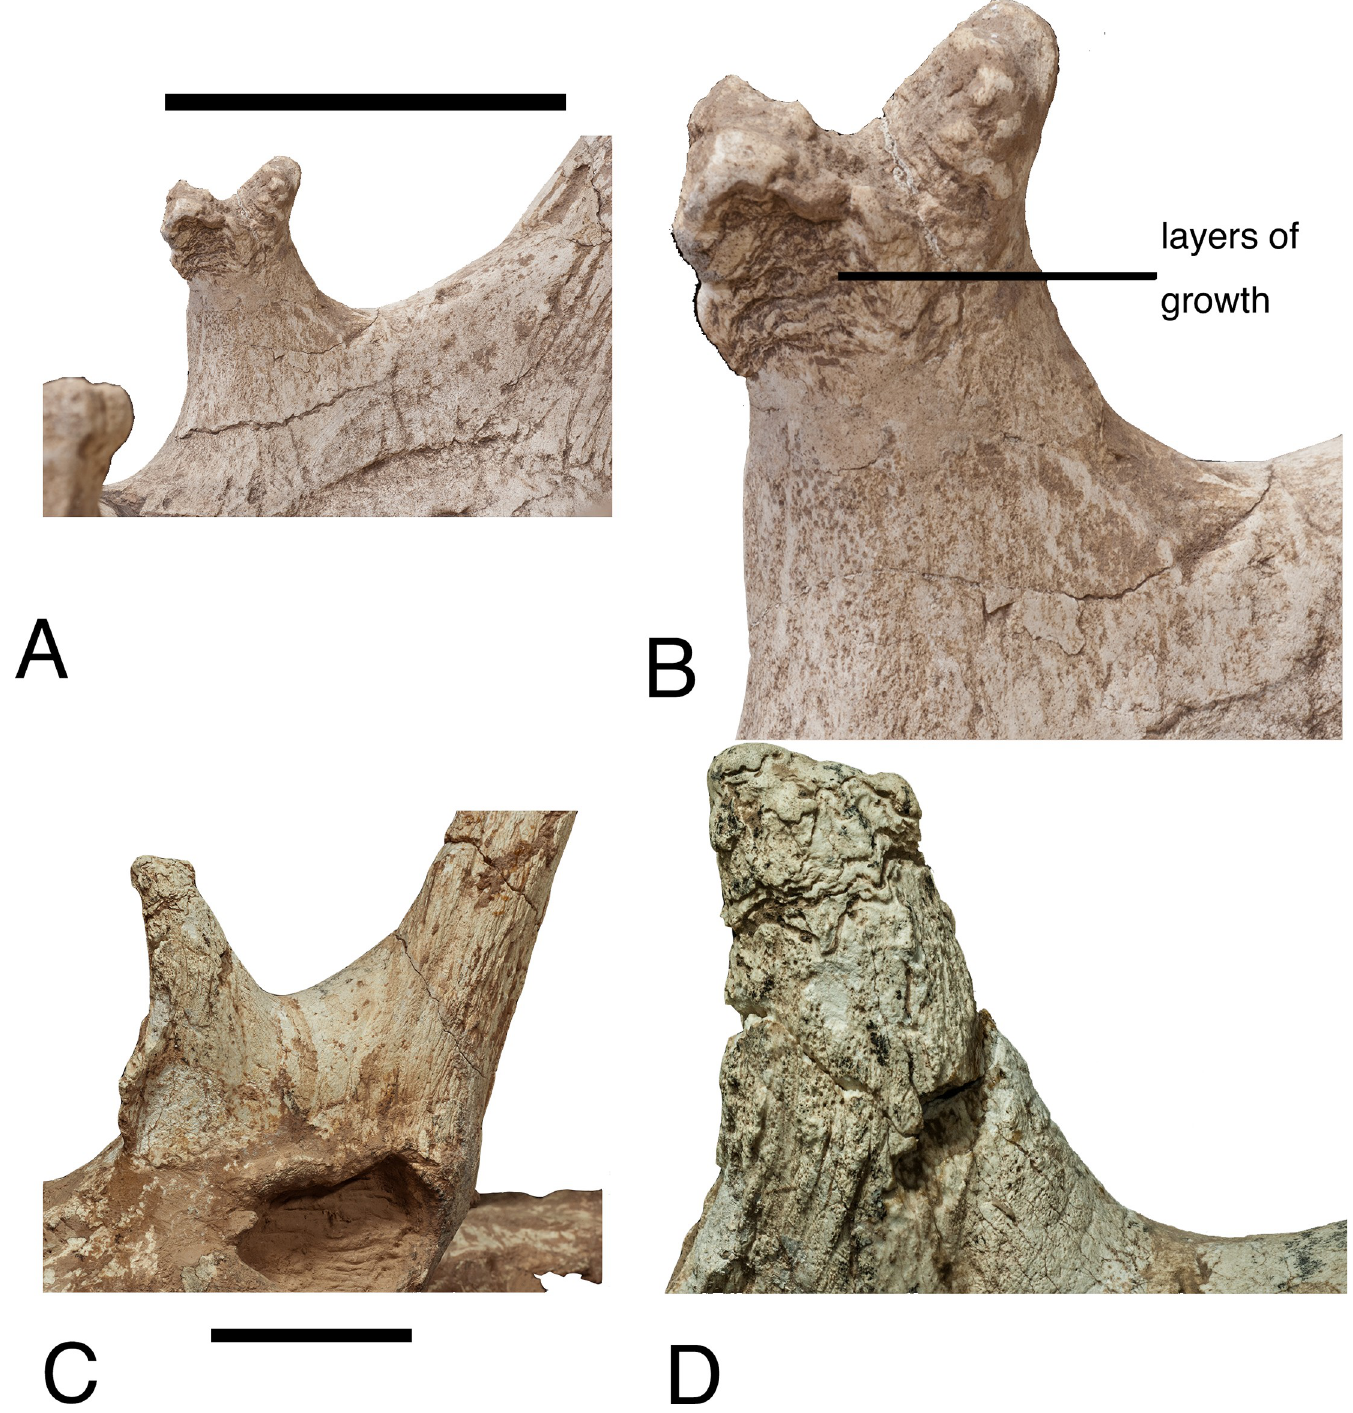
Fig 7. Schansitherium tafeli. (A) HMV 1740 medial aspect of anterior ossicone. (B) HMV 1740 close aspect of same specimen as Fig 7A showing layering. (C) HMV 1931 lateral aspect of orbit and ossicones. (D) HMV 1931 close image of 1931 showing layering. Scale 50mm.